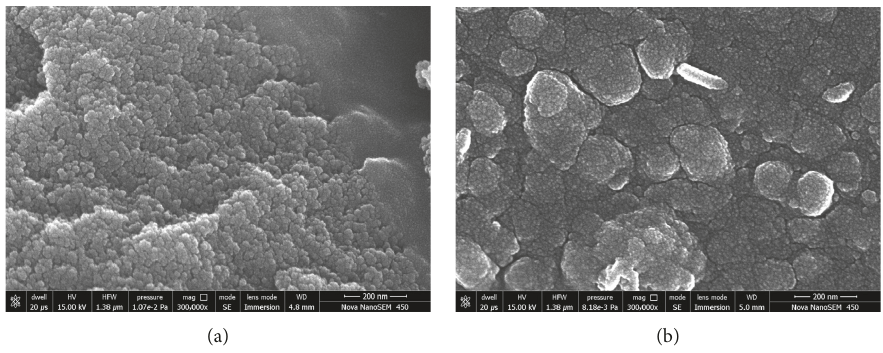
Figure 5: SEM images of as-deposited (a) and annealed (b) InSe thin films.